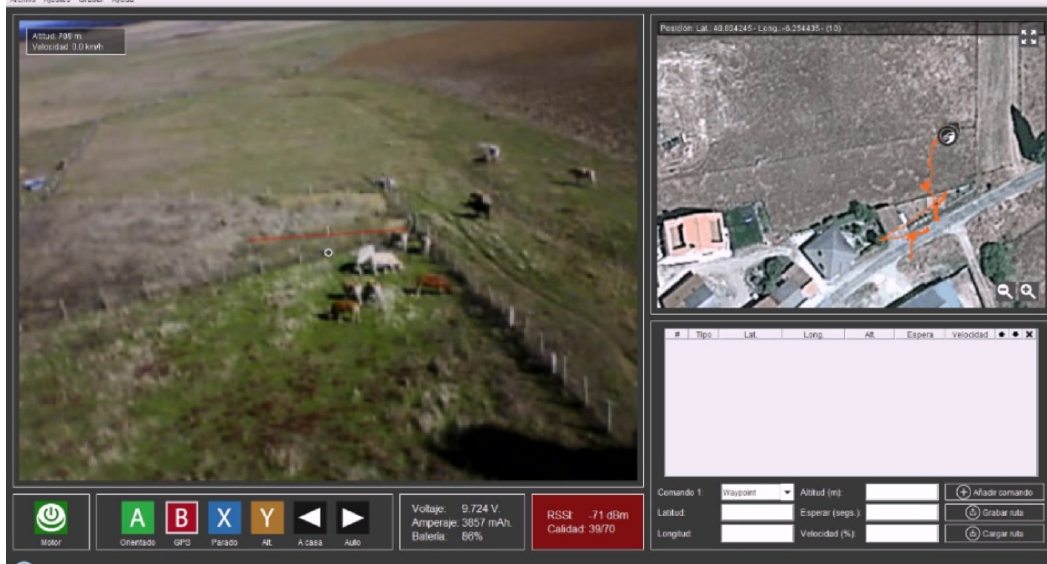
Figure 2. Software developed to monitor all the information in real time [41].